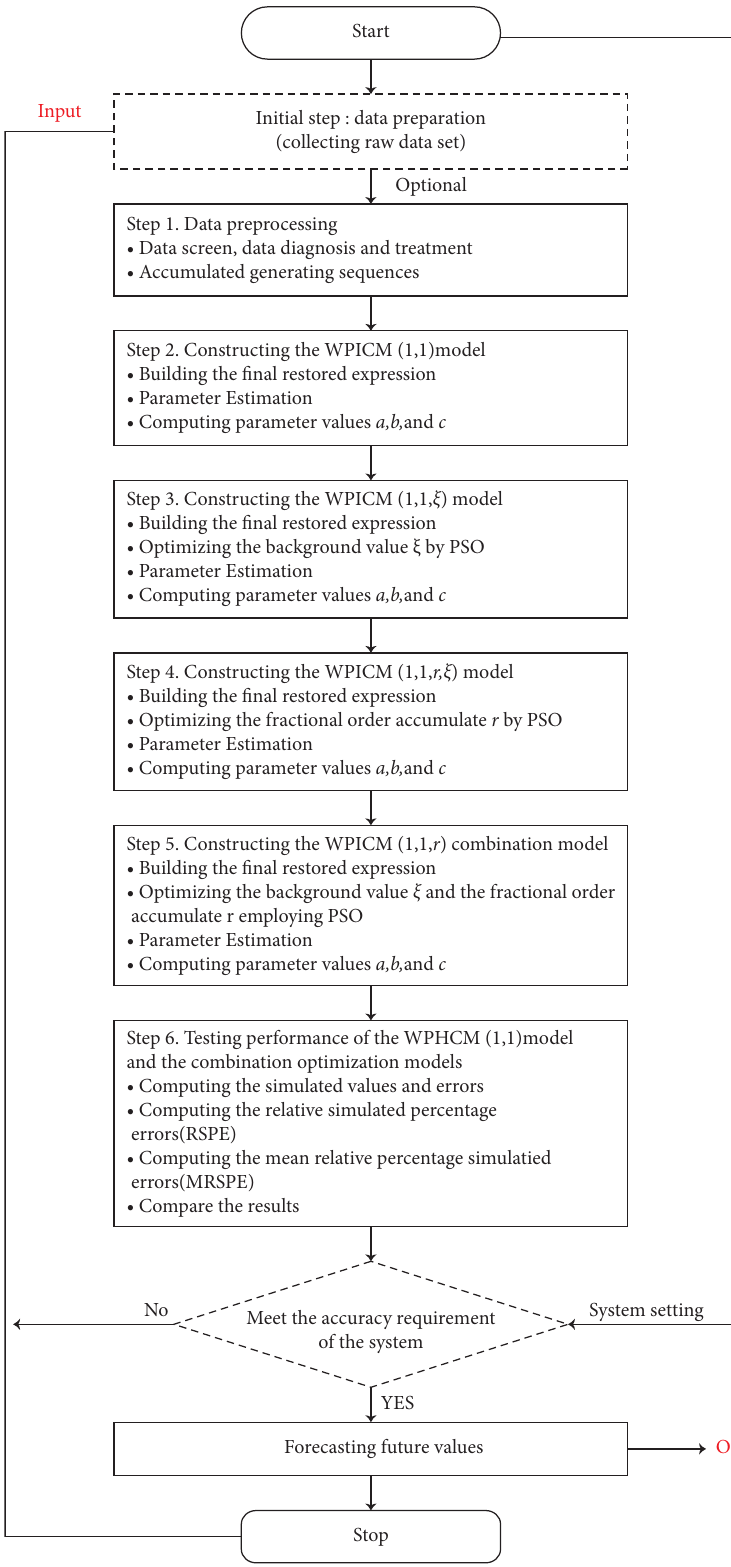
Figure 4: Flowchart of constructing the WPICM ( 1 , 1 , r, ξ ) combination